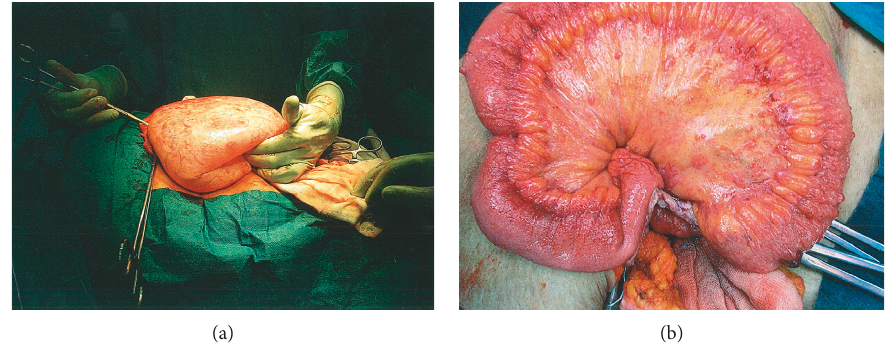
Figure 3: Intraoperative findings. (a) Large ovarian cyst with smooth surface; (b) characteristic nodules on surface of omentum and inflammatory changes of small